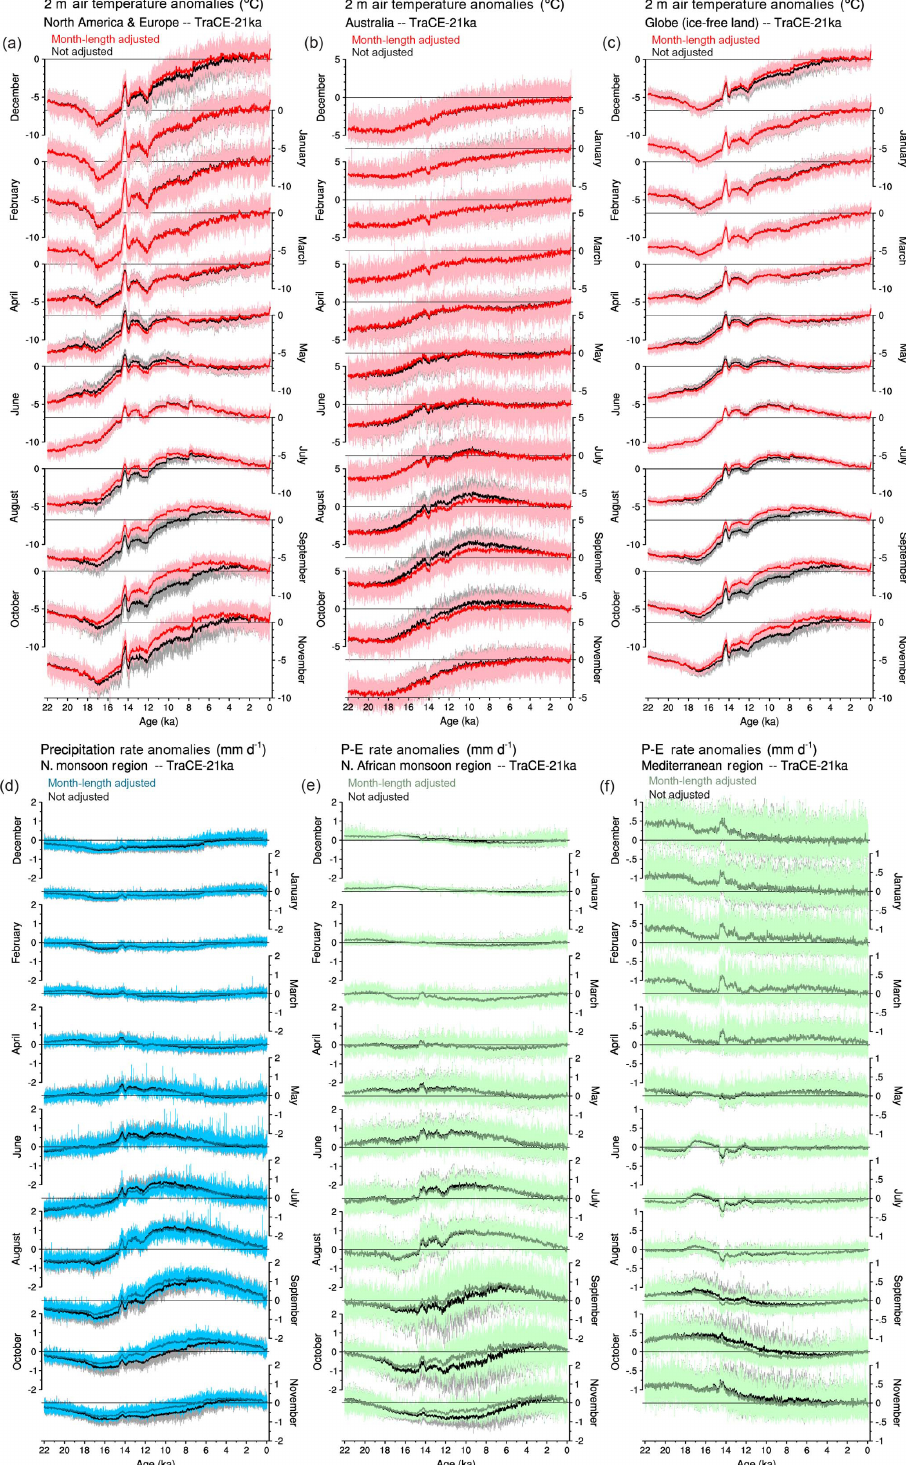
Figure 14. Time series of original and month-length adjusted annual area-weighted averages of TraCE-21ka data (Liu et al., 2009), expressed as differences from the 1961–1989 long-term mean for (a–c) 2m air temperature, (d) precipitation rate, and (e–f) precipitation minus evap- oration ( P − E ). The original or unadjusted data are plotted in gray and black, and the adjusted data are in color. The area averages are grid-cell area-weighted values for land grid points in each region, and the smoother curves are locally weighted regression curves with a window half-width of 100 years. The regions are defined as (a) 15 to 75 ◦ N and − 170 to 60 ◦ E, (b) 10 to 50 ◦ S and 110 to 160 ◦ E, (c) global ice-free land area, (d) 0 to 30 ◦ N and − 30 to 120 ◦ E, (e) 5 to 17 ◦ N and − 5 to 30 ◦ E, and (f) 31 to 43 ◦ N and − 5 to 30 ◦